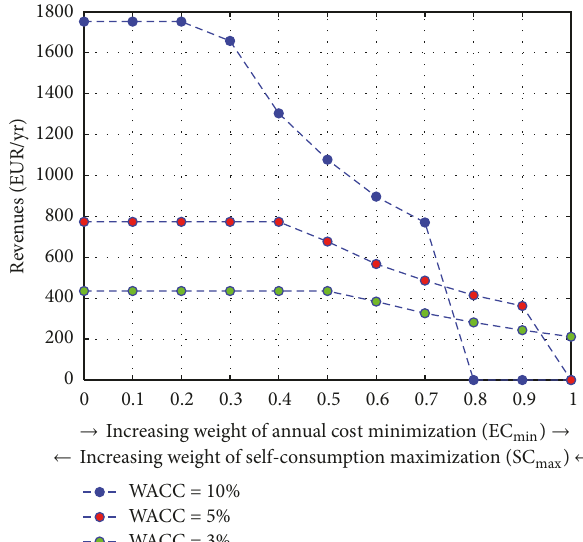
Figure 21: German retail electricity prices: annual electricity cost difference. Figure 22: Austrian retail electricity prices: revenues for property owners for different